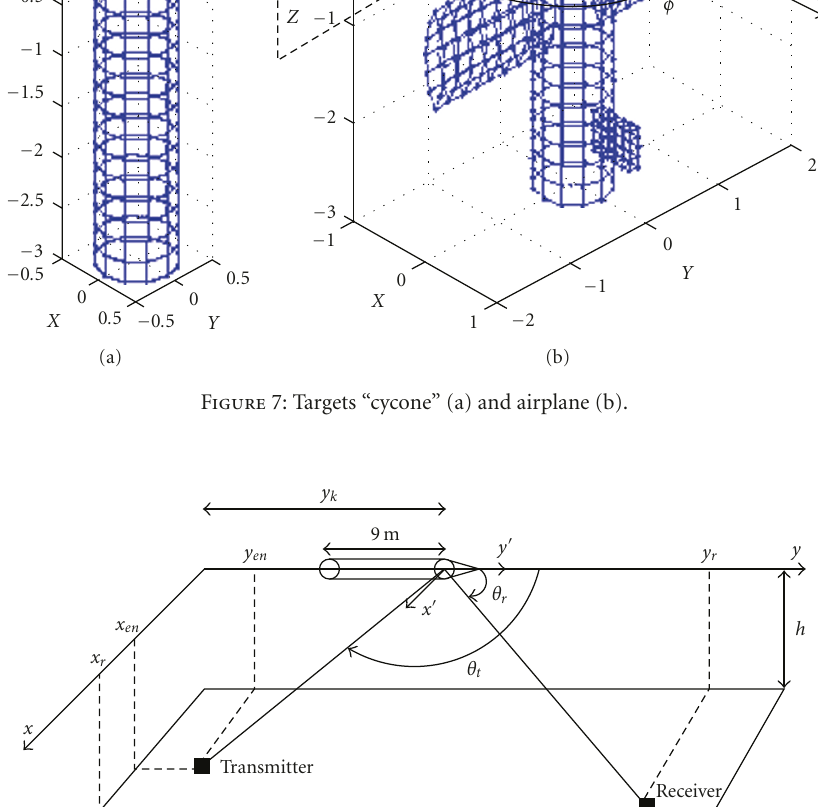
Figure 8: Target position in the moving coordinate system R (cid:2)